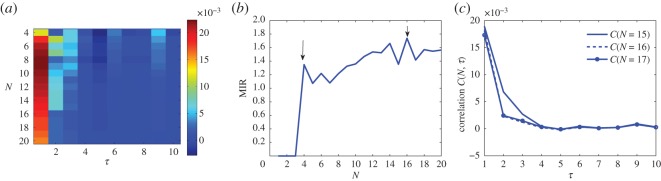
Correlation and MIR for determining the resolution of the partition, which in turn provides the grouping of words. (a) Correlation for different partitions, as a function of N and τ. (b) MIR as a function of N for L=4. Maximization of MIR is attained for N=16. The arrow shows that maximization is possible for specific N. The N should be a multiple of 4n. (c) Correlation values for N=15, N=16 and N=17 with respect to τ. C(N,τ)≅0 at around τ≥4.